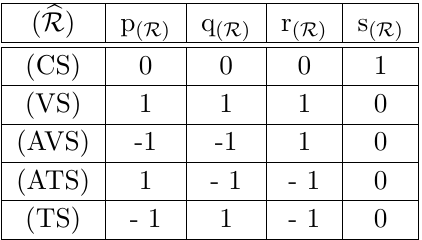
Table 2 . Components for the (CS), (VS), (AVS) (ATS), and (TS) supermultiplets.